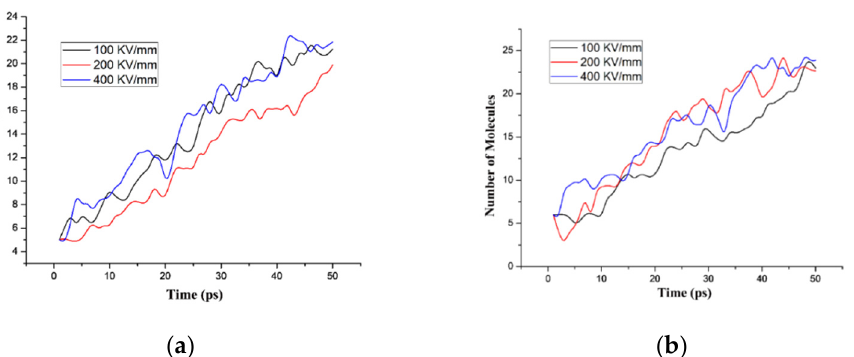
Figure 9. Molecular number of the different systems at three electric fields with the same order of magnitude. ( a ) PI neat; ( b ) PI/BNNS.